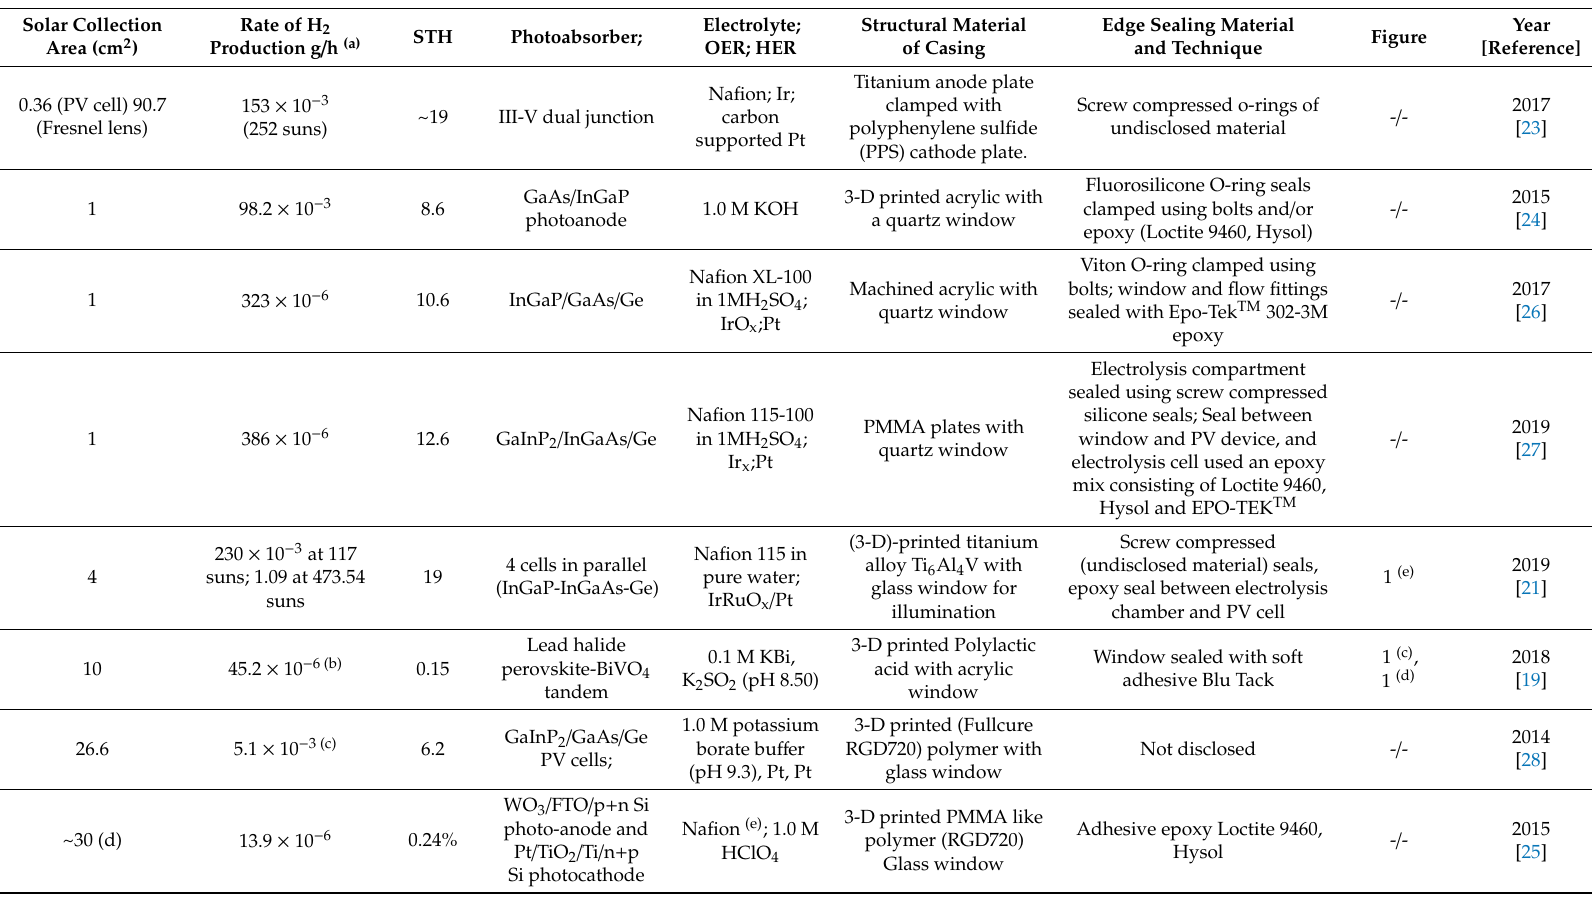
Table 1. Survey of state of the art PEC laboratory prototypes and demonstrators listing casing materials and edge sealing techniques. Solar Collection Rate of H 2 STH Photoabsorber; Area (cm 2 ) Production g / h (a)